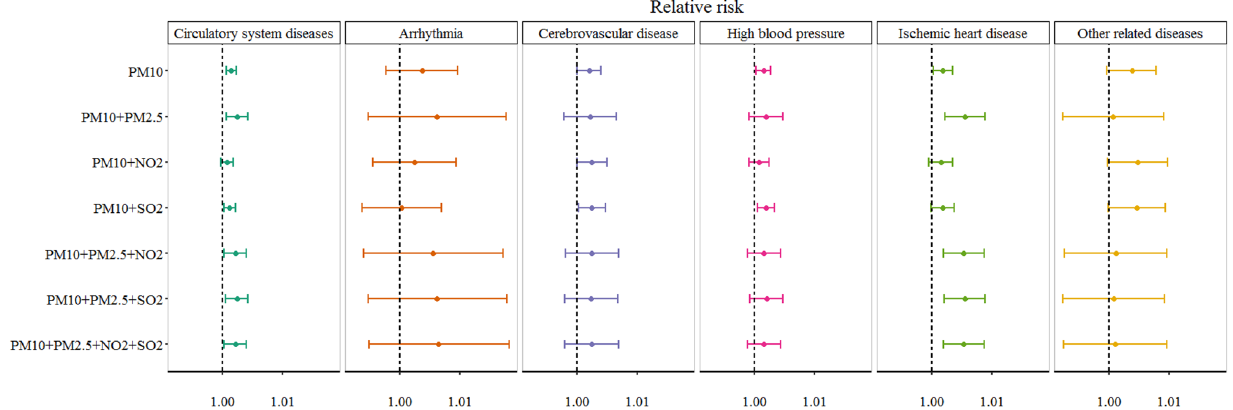
Figure 5. Effects of PM 10 exposure on emergency room visits after adjusting for PM 2.5 , NO 2 , and SO 2 .